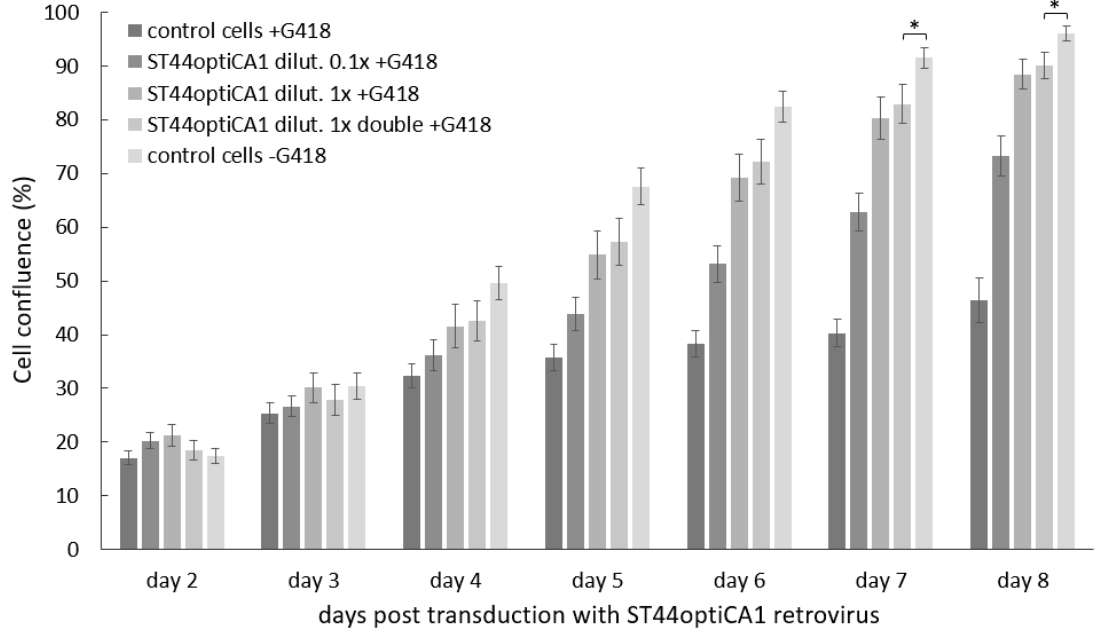
Figure 3. Proliferation of transduced tumor cells overexpressing optimized human CA1 gene from ST44optiCA1 provirus. Virus containing medium was used diluted 10-times (0.1 × ), undiluted (1 × ) in one transduction or undiluted in two subsequent transductions (1 × double). G418–geneticin for selection of transduced cells; kinetic measurement of the cell proliferation is expressed as the cell confluence scanned by IncuCyte ZOOM Kinetic Imaging System; values are expressed as the means of 14-plicates; bars represent SEMs. * statistical significance ( p < 0.05)